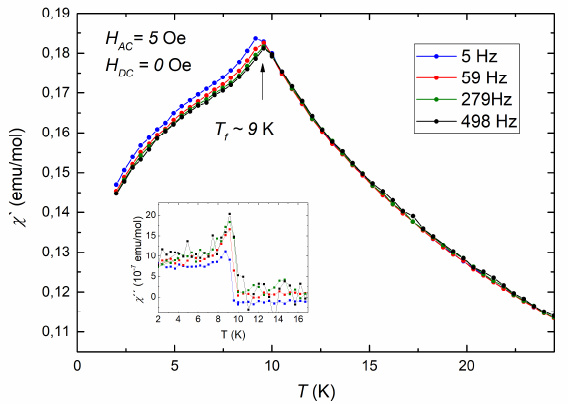
Figure 3. Temperature dependence of the real part of ac susceptibility, measured at different frequency with zero external dc magnetic field (main panel). Bottom inset shows temperature dependence of the imaginary part χ ″ of ac susceptibility.